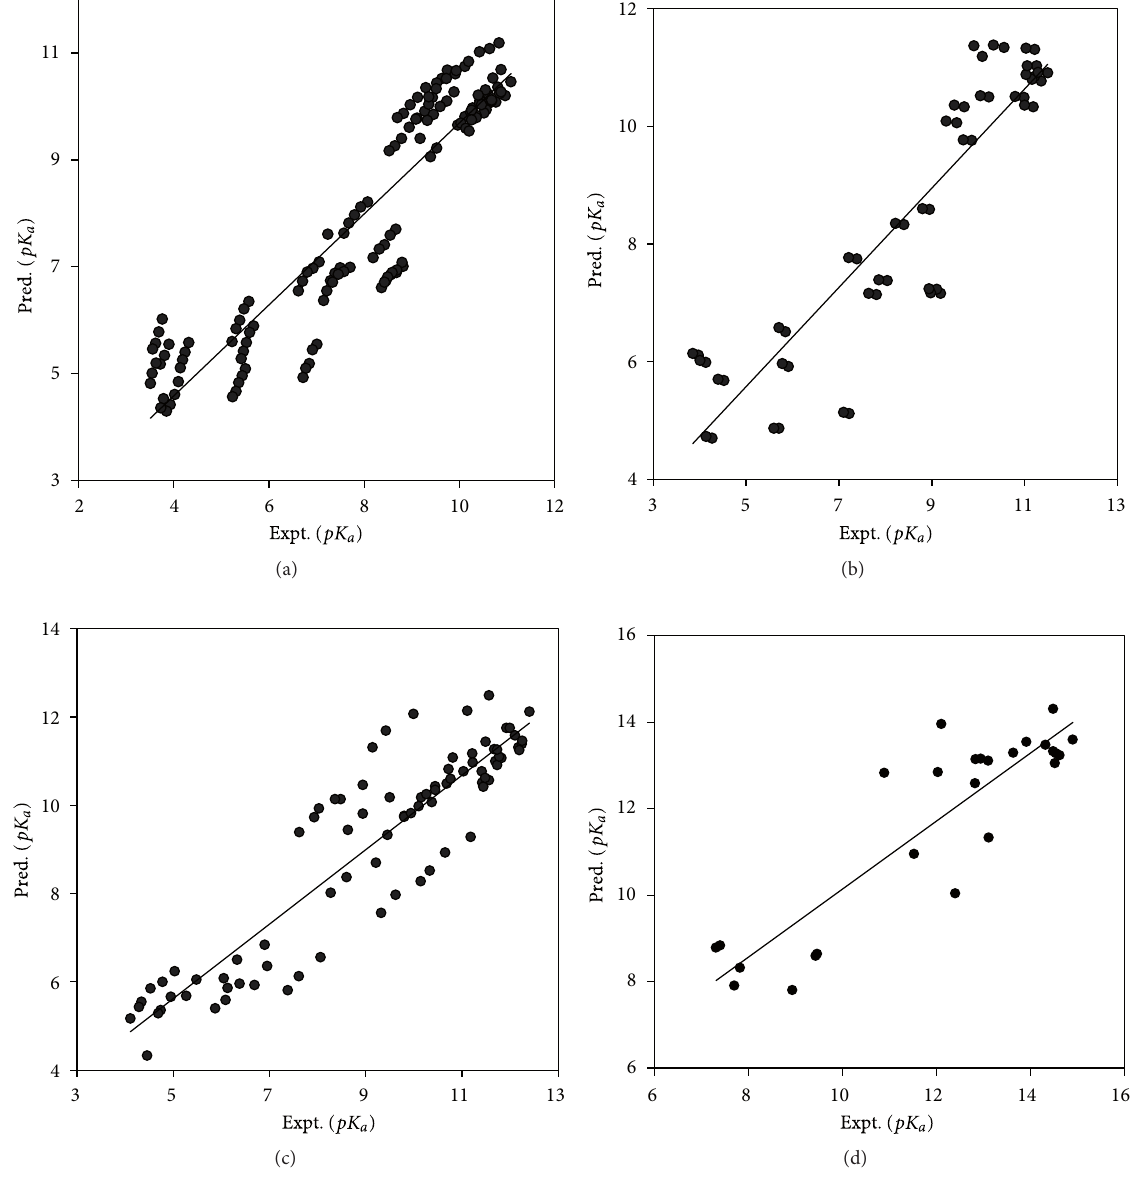
F1: Plotofleave-many-outcross-validationacidityofphenolderivativesin11compositionsofmethanol/watersolvent.Analysisreveals four different categories of their solvation process in the